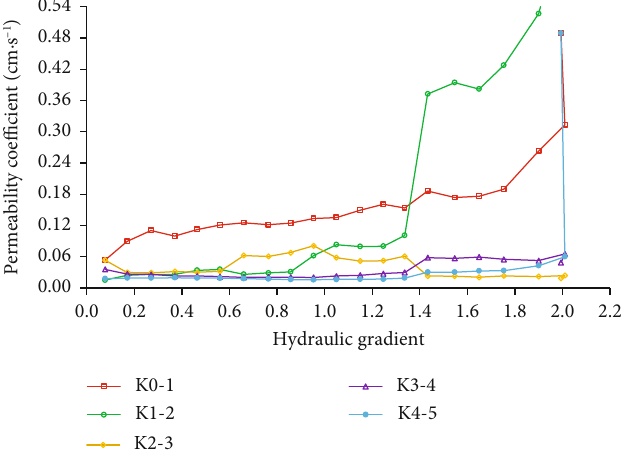
Figure 15: Process curve between hydraulic gradient and permeability of di ff erent parts in soil numbered